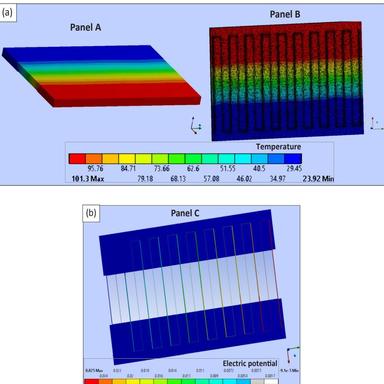
(a) Distribution of the in-plane temperatures in the visible outer region of the TEG-enabled CFRP device with 10 thermocouples (Panel A) and in the cross section (Panel B), which shows the temperature distribution along and around the thermocouples. (b) Distribution of the electric potential along the TEG-consisting thermocouples throughout the TEG-enabled CFRP device (Panel C).